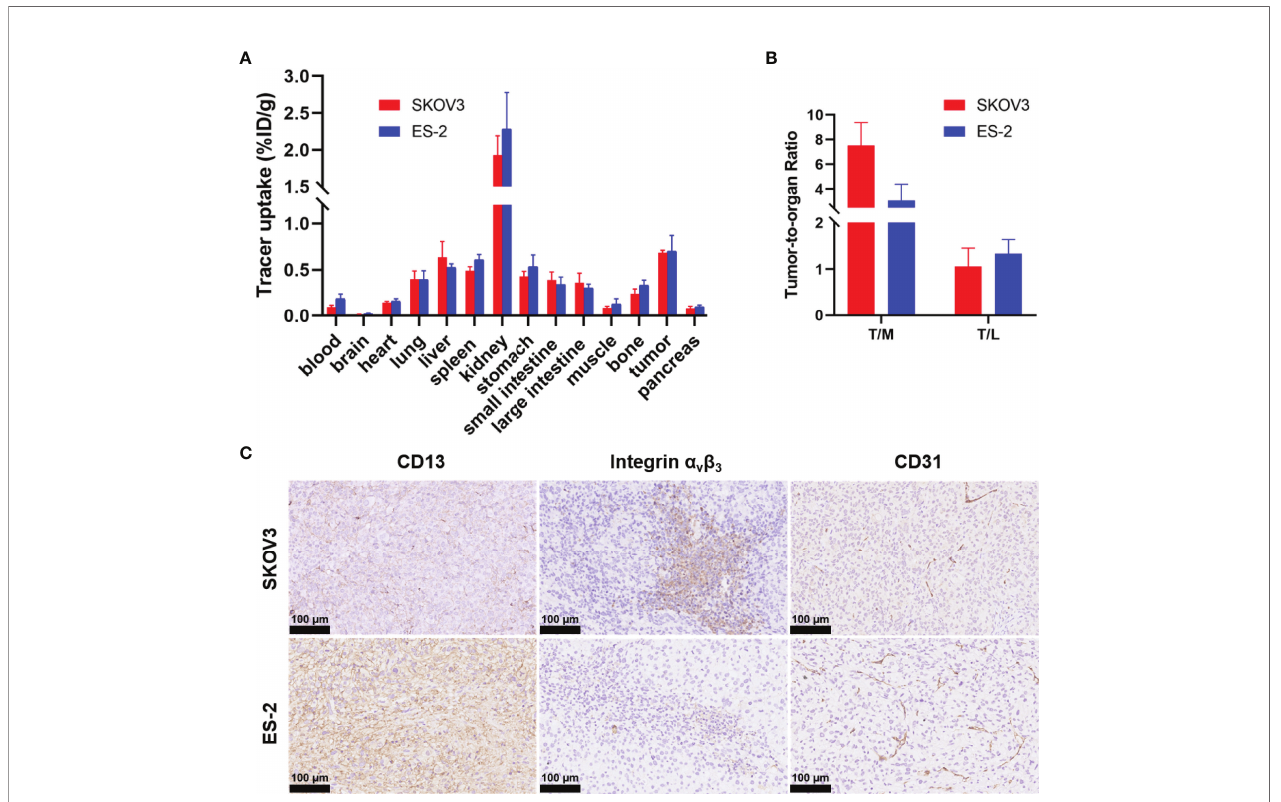
FIGURE 3 | Biodistribution data of 68 Ga-NGR-RGD in ovarian xenograft mice and immunohistochemistry analysis of tumor tissue sections. (A) Biodistribution of 68 Ga-NGR-RGD in SKOV3 and ES-2 subcutaneous ovarian tumor models at 1 h after injection (n = 4). (B) Tumor-to-muscle (T/M) and tumor-to-liver (T/L) ratios of 68 Ga-NGR-RGD in SKOV3 and ES-2 xenograft mice. (C) Immunohistochemistry staining of CD13, integrin a bar = 50 m